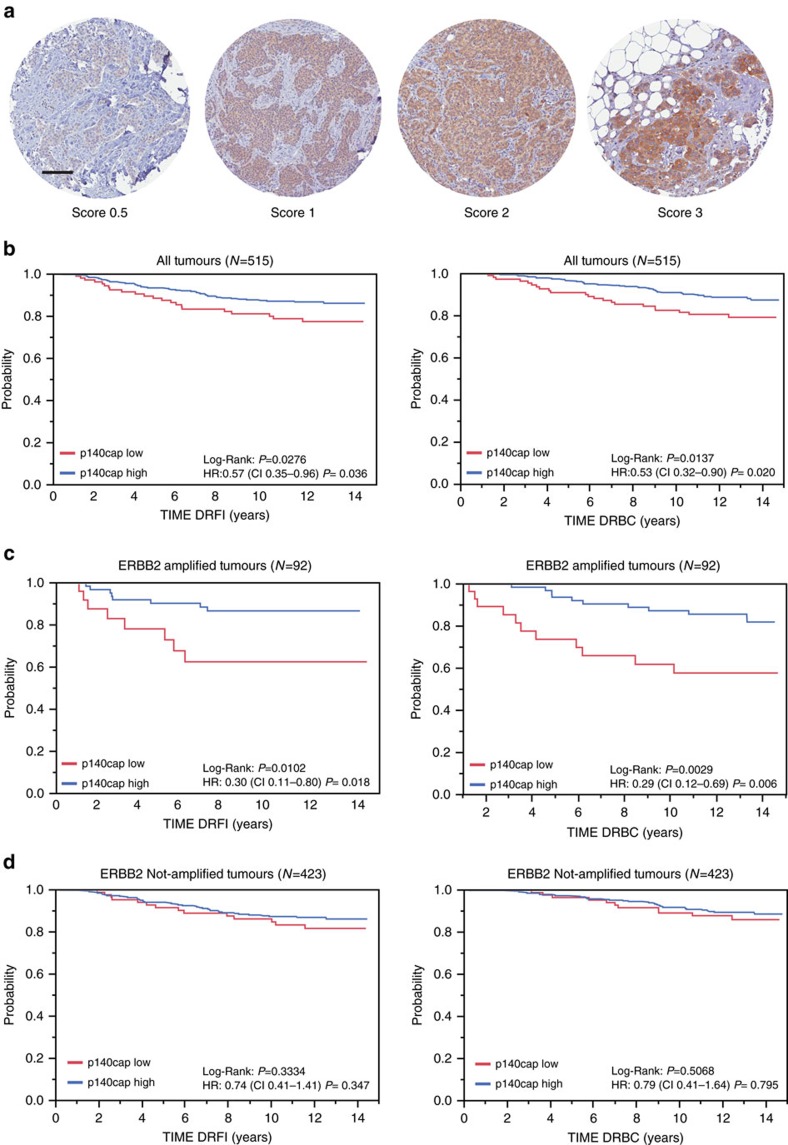
Prognostic relevance of p140Cap expression in breast tumours.(a) p140Cap expression was measured by IHC on tissue microarray (TMA) samples. For the purpose of correlation with clinical and pathological parameters, tumours were classified based on the intensity of p140Cap staining as 0.5–3: p140Cap-Low (IHC score<1) and p140Cap-High (IHC score ≥1). Images are representative of p140Cap expression scoring according to intensity staining in TMA. In tumour tissues, the IHC signals were associated with the tumour cell component and not with the adjacent or infiltrating stroma. TMA data analysis was performed using JMP 10.0 statistical software (SAS Institute, Inc). Scale bar, 100 μm. (b) p140Cap expression in the whole cohort: Distant Recurrence Free Interval (DRFI)65 (left panel: hazard ratio: 0.57, P=0.036); and Death Related to Breast Cancer (DRBC; right panel: hazard ratio: 0.53, P=0.020). (c) p140Cap expression in ERBB2-positive patients: DRFI (left panel: hazard ratio: 0.30, P=0.018); and DRBC (right panel: hazard ratio: 0.29, P=0.006). (d) p140Cap expression in ERBB2-negative patients: DRFI (left panel: hazard ratio: 0.74, P=0.347); and DRBC (right panel: hazard ratio: 0.41, P=0.795). P=Pearson χ2-test.